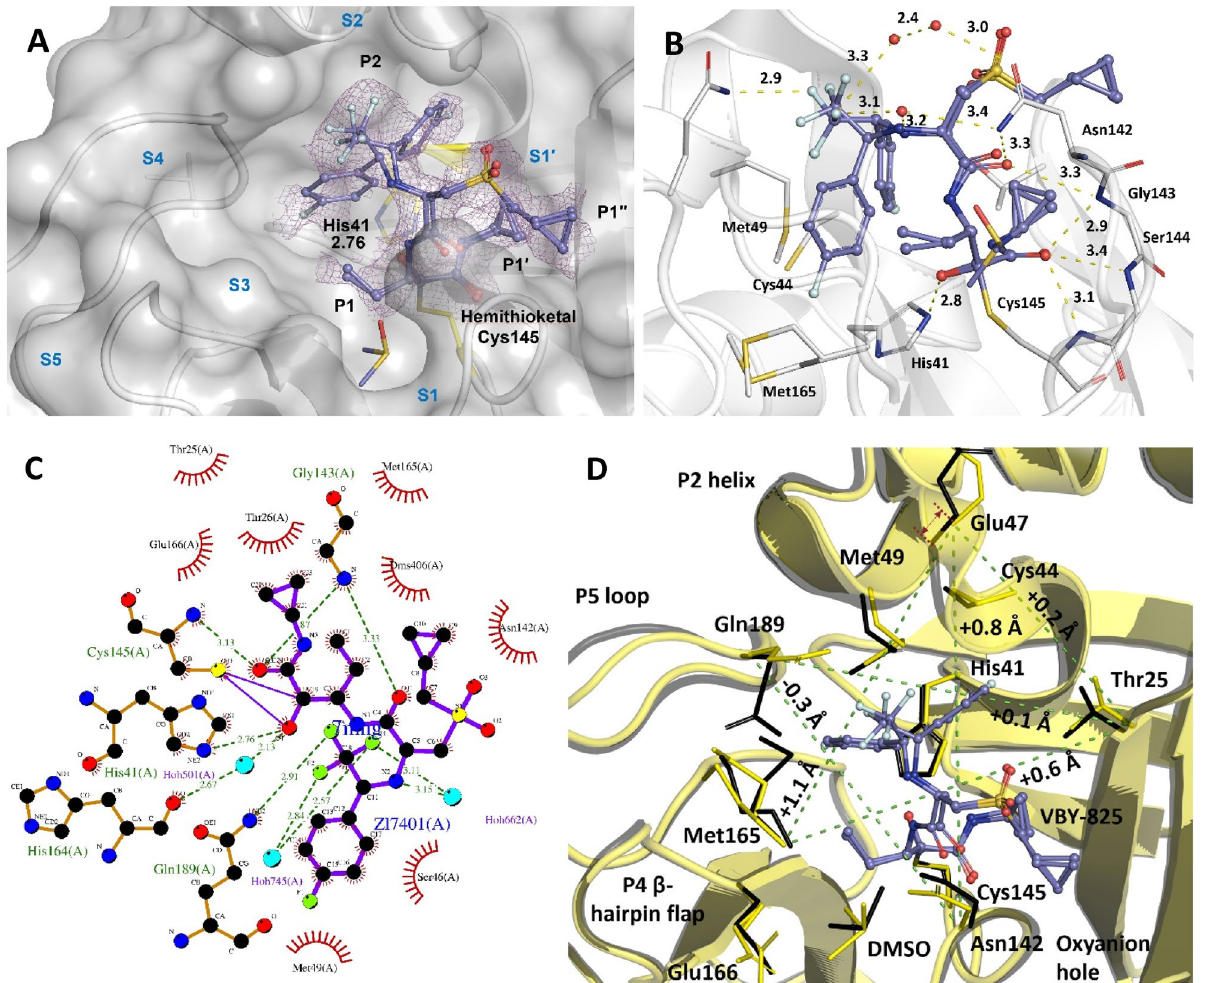
Figure 3. Active subsites of the M pro binding pocket (S1 ′ –S5), ligand functional groups (P1, P1 ′ , P1 ′′ , & P2), and hydrogen bonding interactions of the novel covalent inhibitor VBY-825 with M pro . Two different conformations of VBY-825 are shown. ( A ) Partial electron density of the VBY-825 M pro complex at 1.70 Å resolution and 0.5 rmsd (PDB entry: 7MNG). VBY-825 lacks the P3–P5 functional groups and therefore the associated enzyme subsites are not occupied. Binding of a DMSO molecule to the S1 site forces the VBY-825 to bind in a tilted conformation to Cys145 ( B ) Hydrogen bonding interactions of VBY-825 M pro complex shown for conformer A. Structural water molecules may facilitates the binding of the highly polarized fluorine groups of the trifluoromethyl moiety. A charge-assisted H-bond (CHAB) 35 between H and F is possible, albeit not optimal. ( C ) A detailed 2D LigPlot+ 53 diagram of all the molecular interactions between conformer A of the VBY-825 and M pro is shown. Hydrogen bonds are shown as green dotted lines. Spoked arcs represent nonbonded contacts such as hydrophobic interactions. The solid purple line between Cys145 and VBY-825 represents a covalent binding. ( D ) An overlay (0.28 Å r.m.s.d.) of the apo (black) (PDB: 7K3T) and VBY-825 bound (yellow) (PDB: 7MNG) M pro . The comparative changes in C α distances are shown as green dotted lines with values. Binding of the VBY-825 displaces the P2 helix by 1.1 Å (red arrows) and predominantly displaces the side chains of Gln189 and Met165. However, the conformational changes are less significant in comparison with other HCV NS3/4A inhibitor-M pro complexes 20